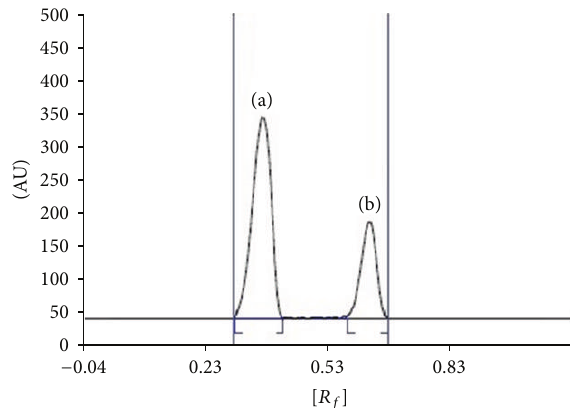
Figure 5: Densitogram obtained from TLM ( 𝑅 𝑓 0.37 ) and ATV ( 𝑅 𝑓 0.63 ) at 279nm.